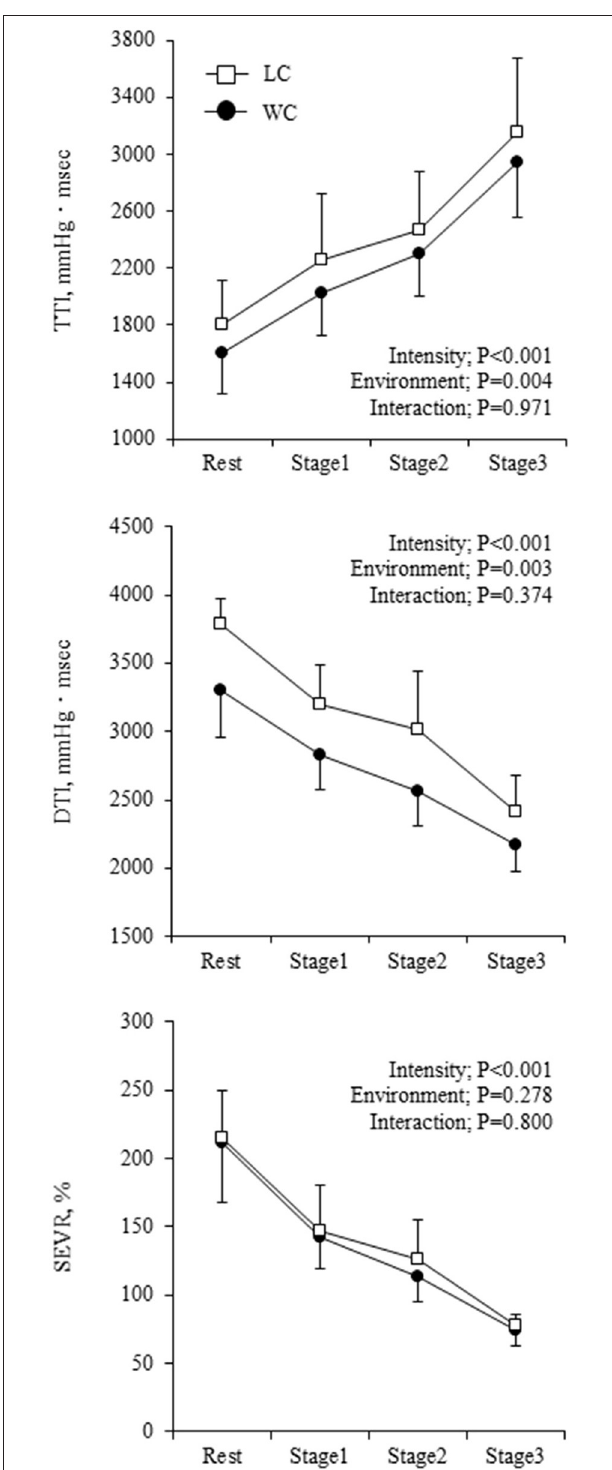
FIGURE 3 | Myocardial oxygen supply-to-demand balance indicators at rest and during exercise. Symbols and error bars are mean and SD. The circle and square indicate water-based and land-based exercise, respectively. The P -values for the two-way repeated ANOVA data are presented (intensity, environment, and interaction).